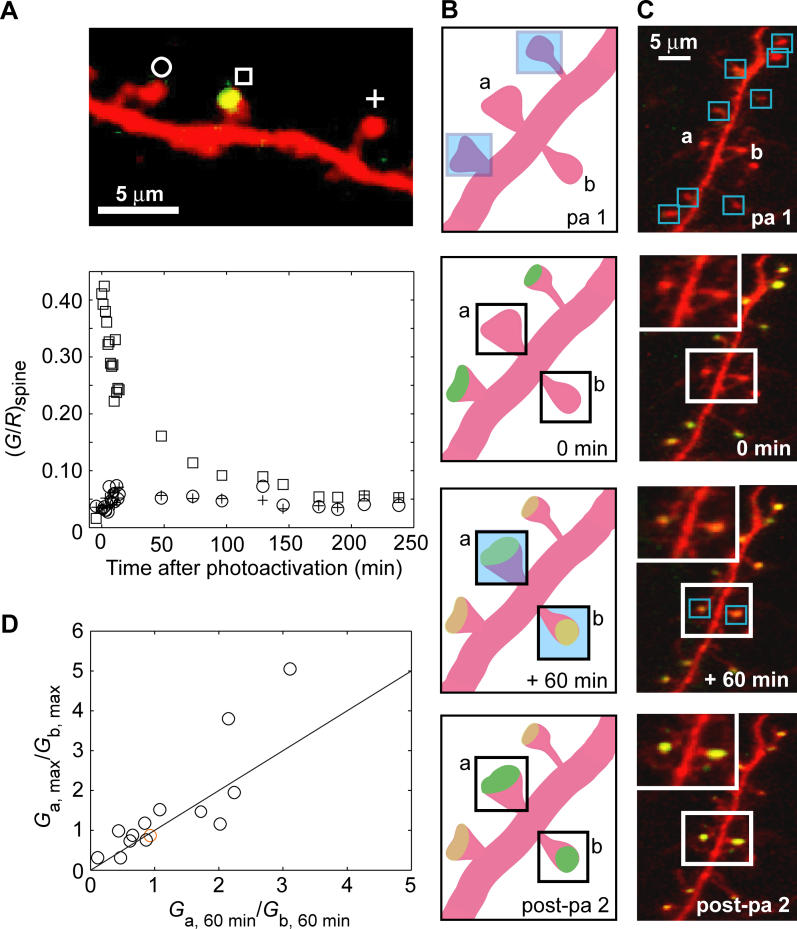
Individual PSDs Share a Common Pool of PSD-95(A) Photoactivation of PSD-95-paGFP in a single spine (square) is followed by an increase in green fluorescence in neighboring spines (circle and cross). Top, image. Bottom, corresponding fluorescence time course. Green fluorescence was normalized to red fluorescence in the spine.(B) Measuring the relationship between PSD-95 capture and PSD size. All but two (pa 1, a and b) “probe” spines were photoactivated. The fluorescence intensity within the probe spines was quantified (G
a and G
b) after 60 min. Subsequently the probe spines (a and b) were also photoactivated to estimate the sizes of their PSDs (post-pa 2, [G
a, max and G
b, max]).(C) Time-lapse images corresponding to (B). Insets show the probe spines a and b. Note, the last image was acquired after the probe spines were fully photoactivated.(D) Larger PSDs capture more PSD-95. Comparisons were performed for pairs of spines, a and b. The PSD size ratio (G
a,max/G
b,max) was proportional to the ratio of capture (G
a,60min/G
b,60min) (orange circle corresponds to the spine pair in [C]).